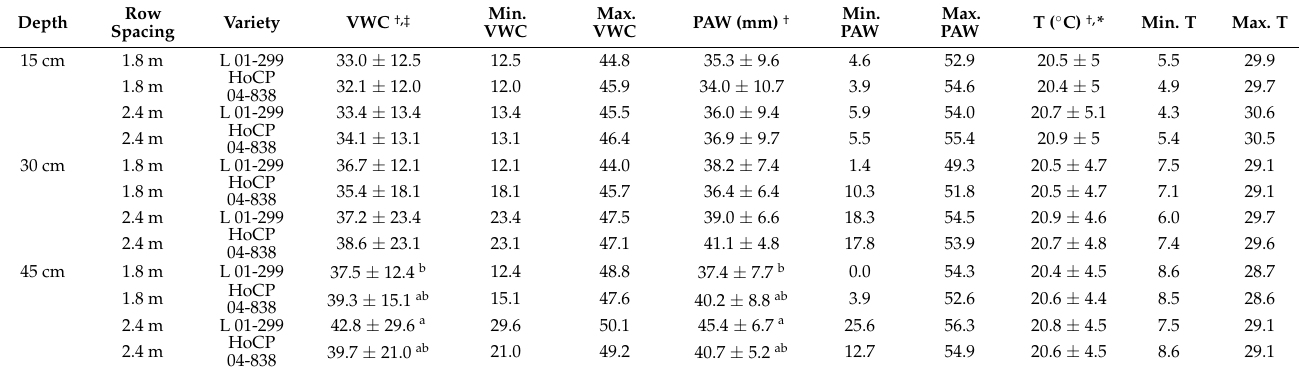
† At depths 15 and 45 cm, VWC and PAW were greater in 2.4 m rows than in 1.8 m ( p < 0.05 for both depths). Rows of 2.4 m were greater than 1.8 m rows in all depths for T ( p < 0.0001 for all depths). VWC, PAW, or T were not significantly different with variety at each depth ( p > 0.05). ‡ At depth 45 cm, VWC and PAW followed by the same letter are not significantly different. * T was slightly greater in L01-299 than HoCP 04-838 at 30 cm soil depth.